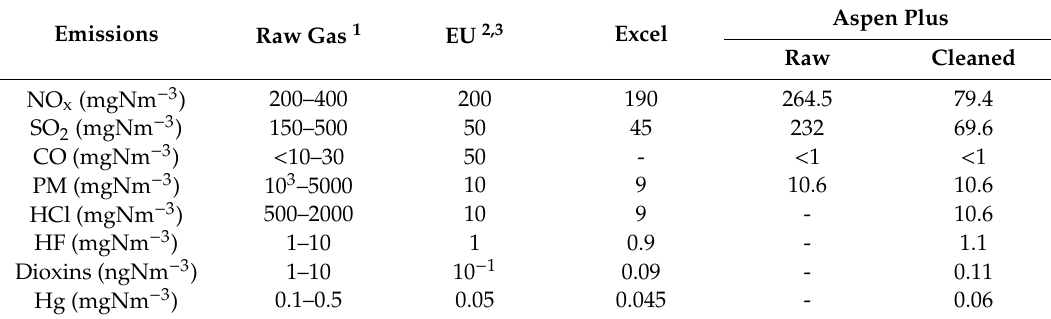
Table 4. Emissions for a large-scale waste-to-energy plant in